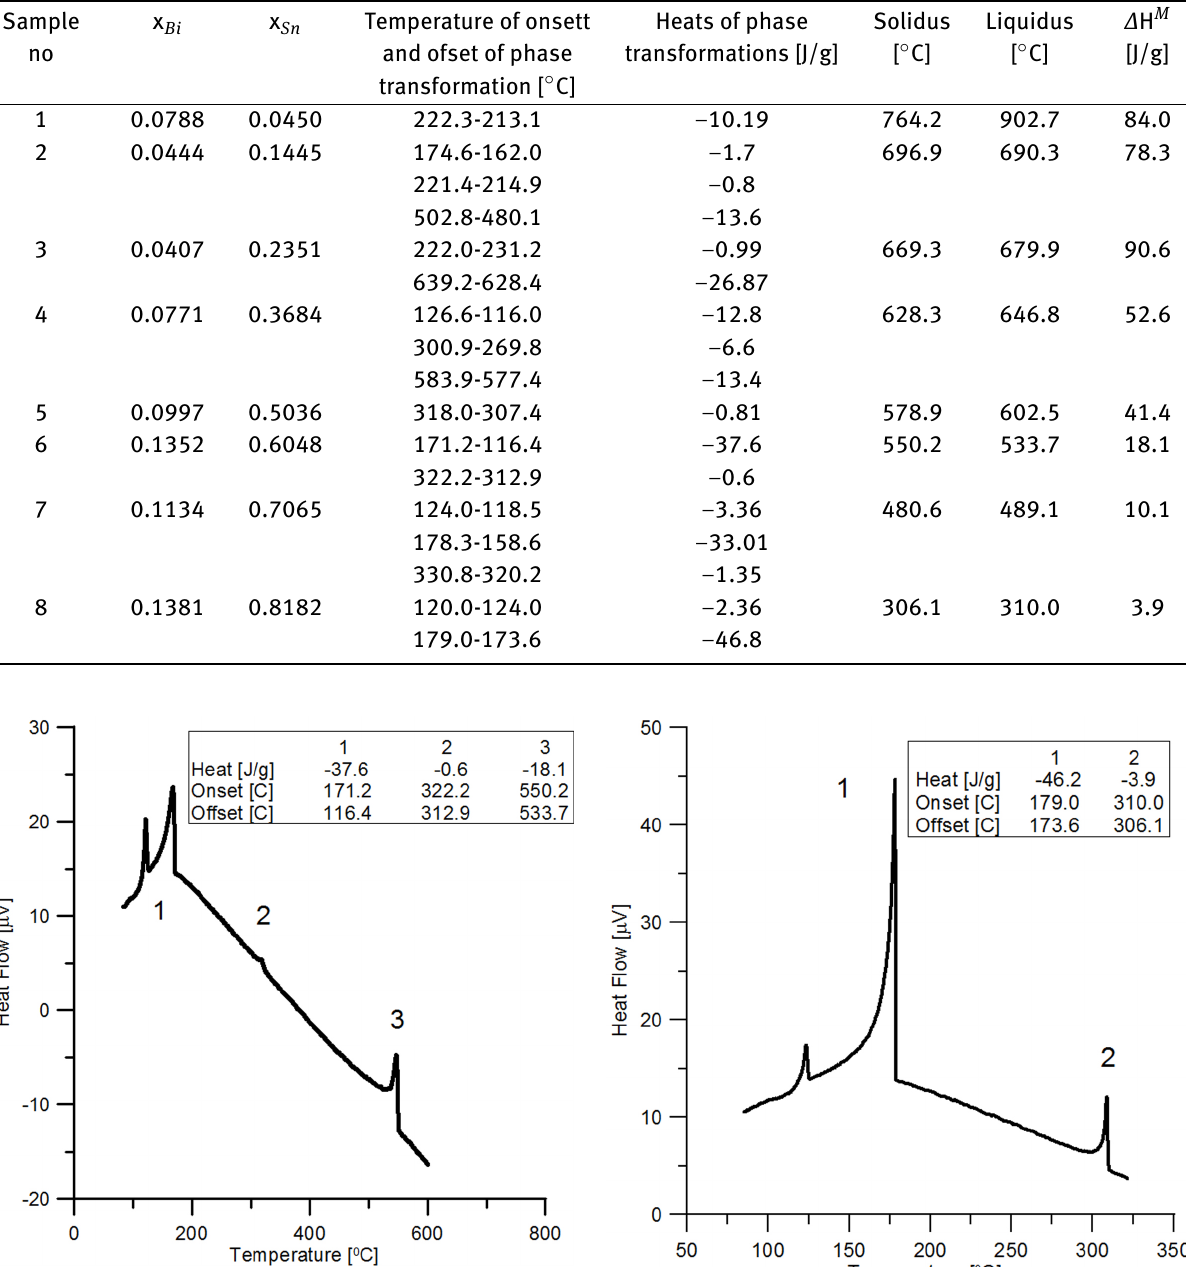
Table 1: Experimental temperatures and heat effects of phase transformations in Bi-Cu-Sn alloys. Sample